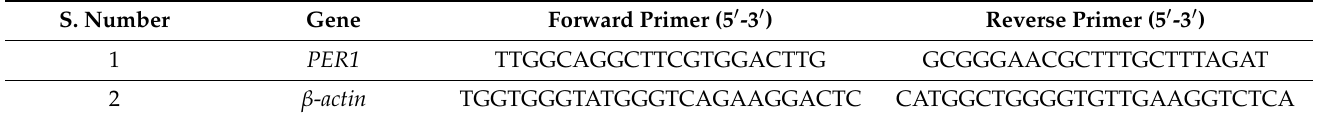
(Table 2), along with the SYBR Green master mix. A Step OneTM Real-Time PCR System (Applied Biosystems, Foster City, CA, USA) was used for the assessment of the samples. Along with the gene of interest, β -actin was run as a reference control to normalize gene expression. The reaction procedure entailed a time duration of 10 min at 950C, followed by 45 cycles at 950C (15 s) and 600C for 1 min. All the experiments were performed in triplicates, along with negative and positive controls. The expression fold change of PER1 mRNA from different samples were calculated with reference to the normal control group based on the threshold cycle (CT) values by using the following formula: Relative ∆∆ CT Quantification (RQ) = 2 − . Table 2. Quantitative/real-time PCR primer